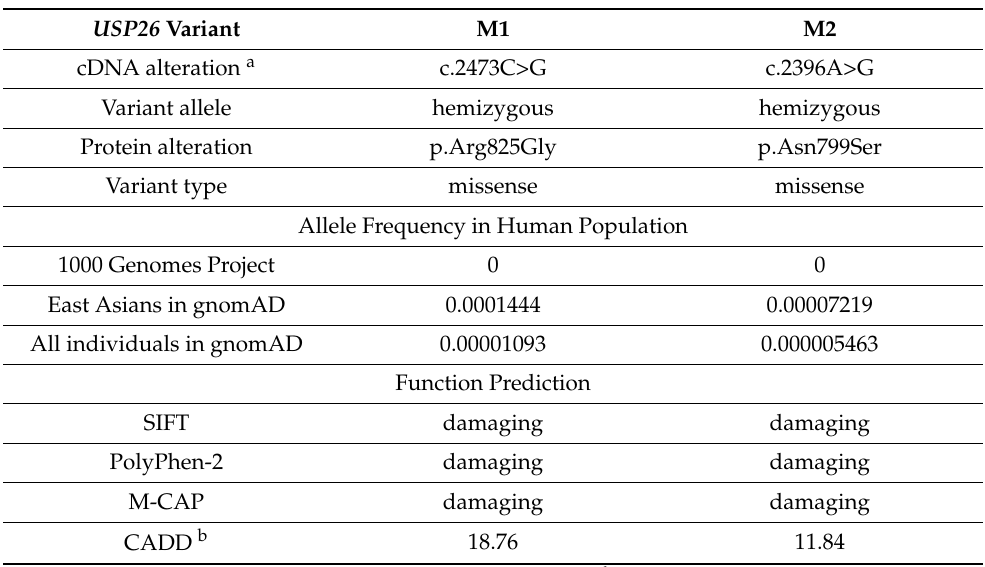
Table 1. Hemizygous deleterious USP26 variants identified in Chinese men with asthenoterato-